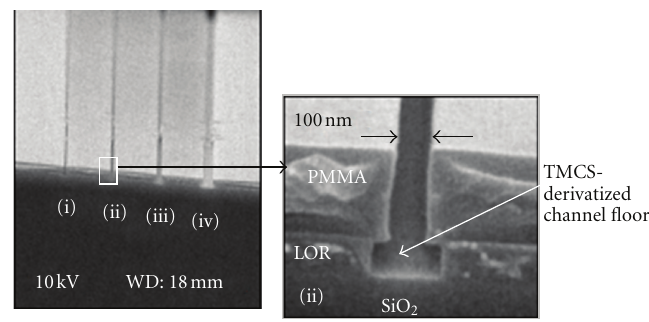
Figure 1: Scanning electron micrographs showing nanostructured surface produced by electron-beam lithography applied to bilayer resist layer on SiO 2 , consisting of lift-o ff resist (LOR) and polymethylmethacrylate (PMMA). Following electron-beam exposure and development, the PMMA layer was made hydrophilic by oxygen-plasma ashing followed by trimethylchlorosilane (TMCS) derivatization of the exposed SiO 2 . The nanoscale track illustrated here has similar walls as the motility supporting open areas illustrated below (e.g., Figure 4).